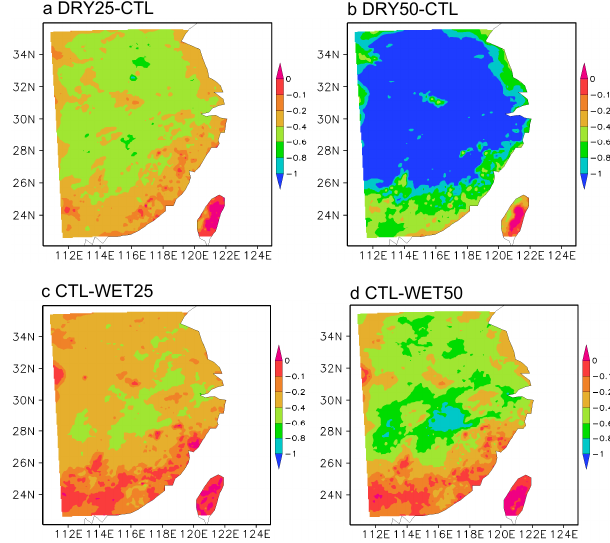
Figure 13. The 10-day mean 06:00UTC surface pressure difference fields as compared between different groups of simulations (unit: